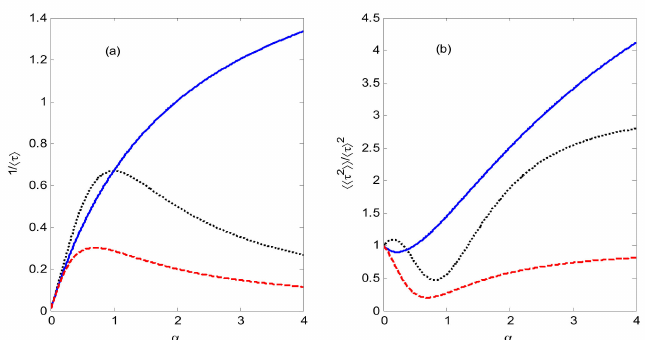
Figure 1. ( a ) 1/ (cid:104) τ (cid:105) as a function of α = Γ r / Γ l . ( b ) The randomness parameter, (cid:104)(cid:104) τ 2 (cid:105)(cid:105) / (cid:104) τ 2 (cid:105) , as a function of α . The blue solid line for constructive ( η = 1), red dashed line for destructive ( η = − 1), and black dotted line for η = exp ( i π /2 ) . The variable α stands for the asymmetry of dot-state couplings to the left and right leads. δε = Γ l = Γ 0 .